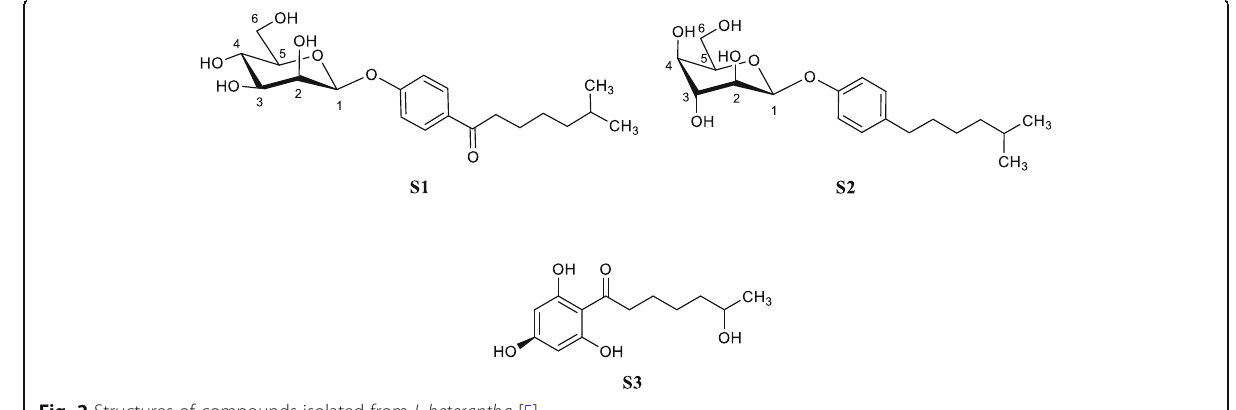
Fig. 2 Structures of compounds isolated from I. heterantha